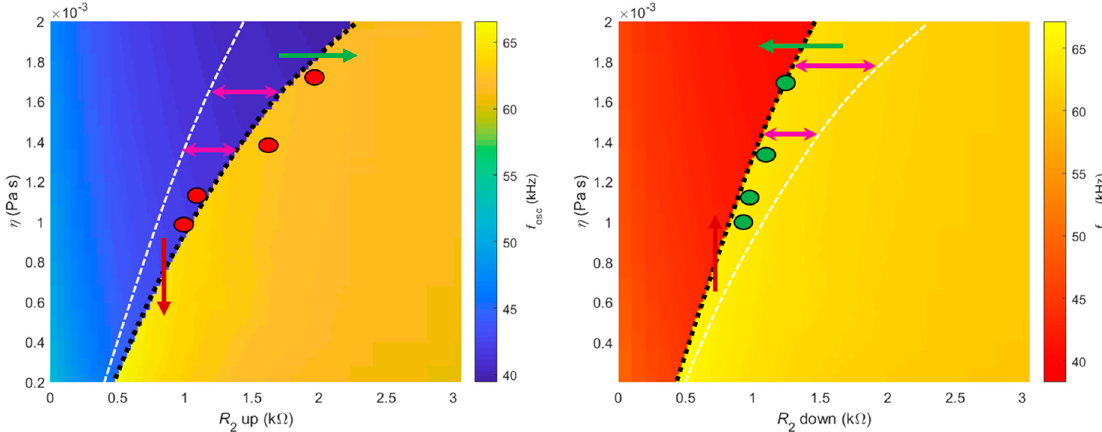
Figure 5. Left and right panels show insets of the oscillation frequency map when R 2 was swept up and down, respectively (Figure 4b, top and bottom rows), with thick, dashed, black lines delimiting the jumps. The red and green circles represent the experimental data measured and presented in Figures 2a,b, for the four glycerol solutions. The thin, white, dashed lines represent the jump delimitation of the opposite panel, for an easier visualization of the two distinct sensing modalities proposed.